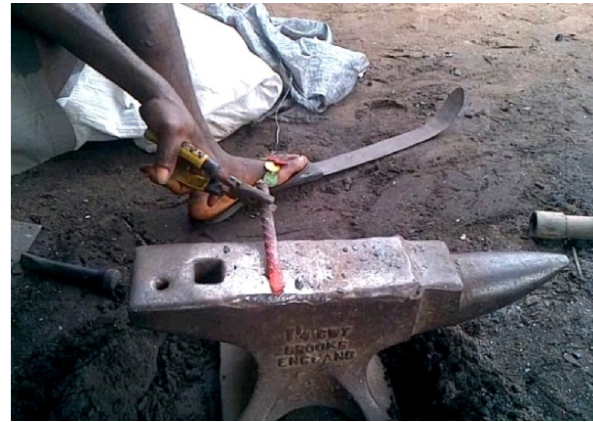
Figure 8 | Firing carbon steel rods in a furnace. Photograph by Kingsley O. Emeriewen, 2013.